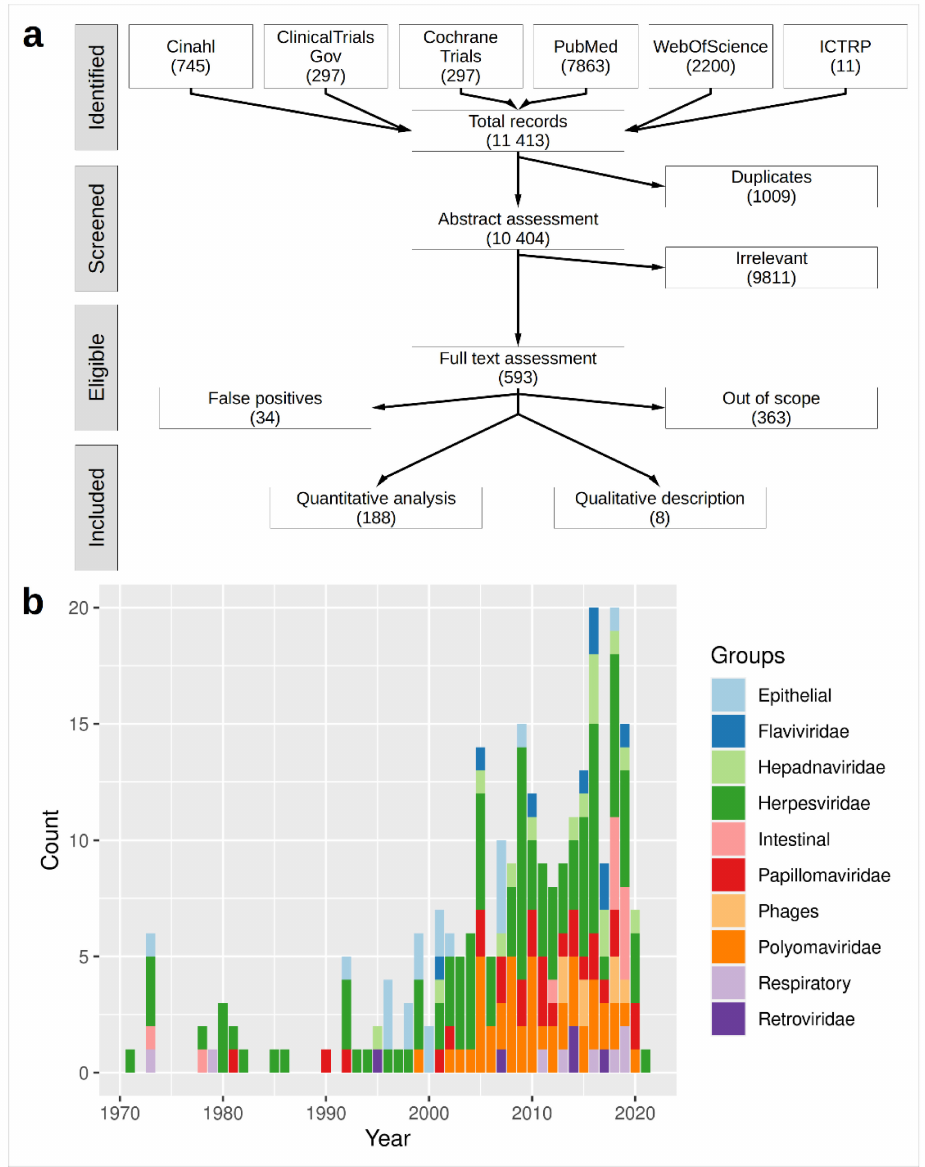
Figure 1. Overview of the present meta-analysis. Study selection was based on the PRISMA standard. ( a ) Flow diagram of the present meta-analysis. ( b ) Stratification of the studies by publication year and virus